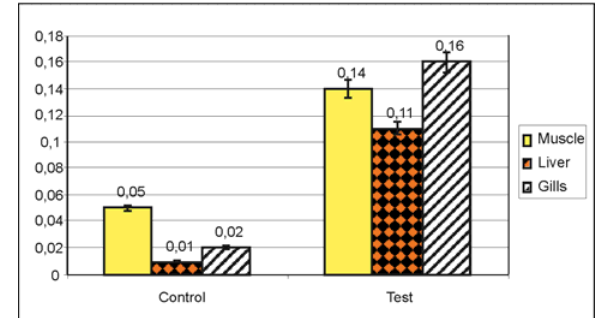
Fig. 13. Chromium concentration (mg/kg) in tissues of rainbow trout